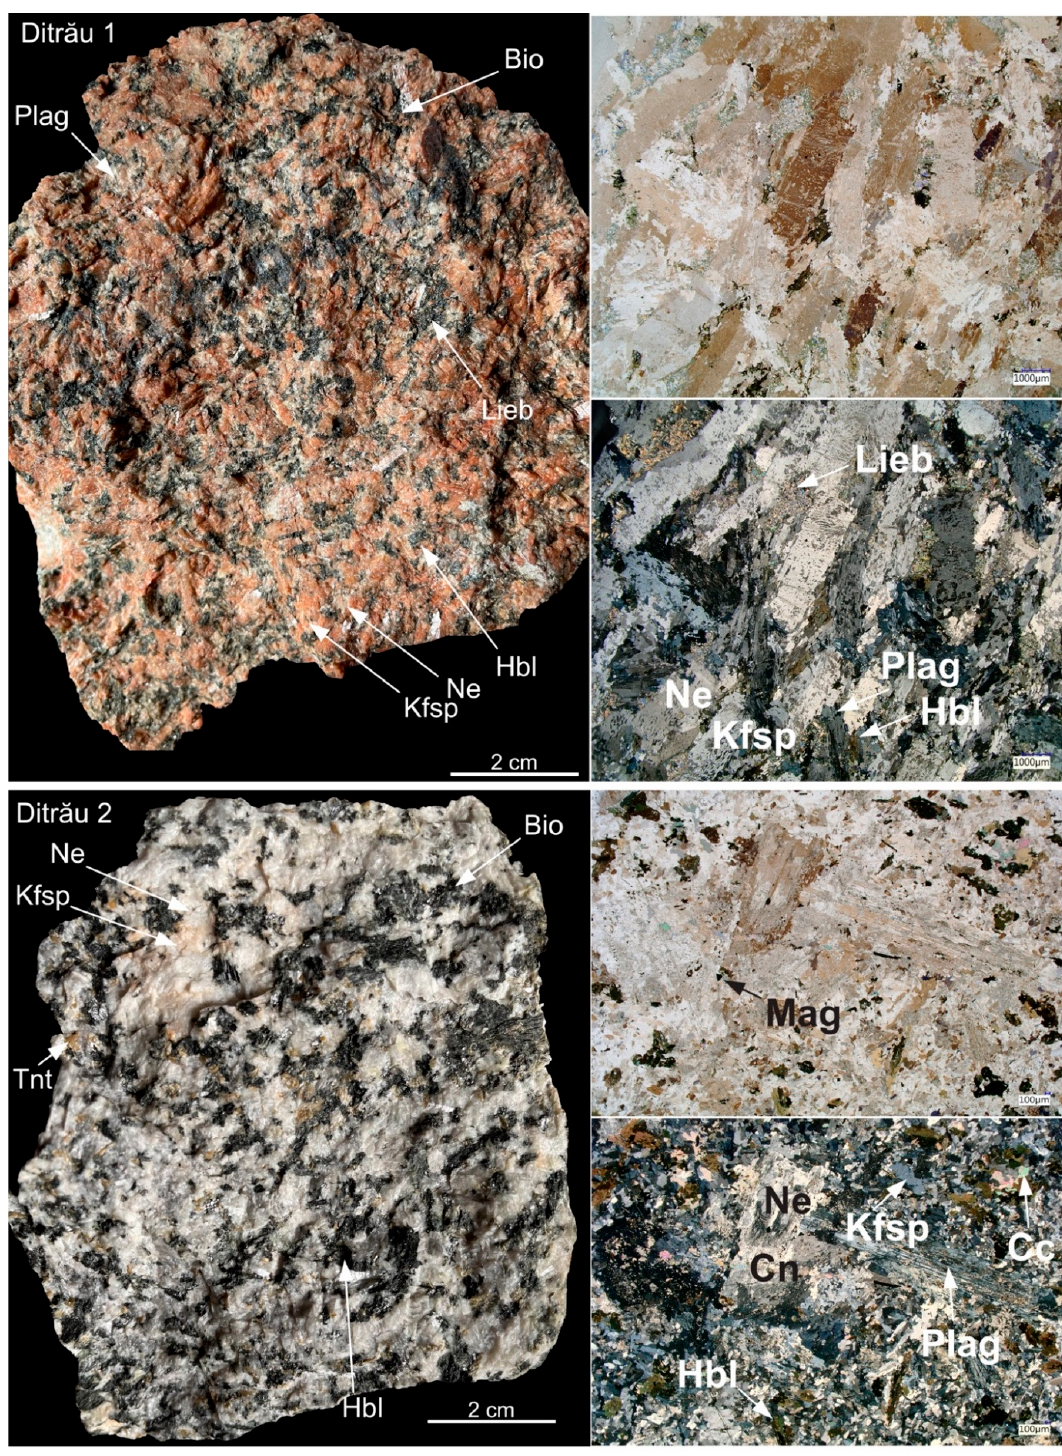
Figure 2. Macro- and microphotographs of the investigated samples from the DAM. (Ditr ă u 1) Hand specimen of the L ă zarea suite nepheline syenite and thin section images. Upper image in plane polarized light, lower image in double polarized light. (Ditr ă u 2) Hand specimen of the Ghidu ţ suite nepheline syenite and thin section images. Upper image in plane polarized light, lower image in double polarized light. In all images the major mineral phases are labelled; Bio = biotite, Cc = calcite, Cn = cancrinite, Hbl = hornblende, Kfsp = potassium feldspar, Lieb = liebernite, Mag = magnetite, Ne = nepheline, Plag = plagioclase, Tnt =